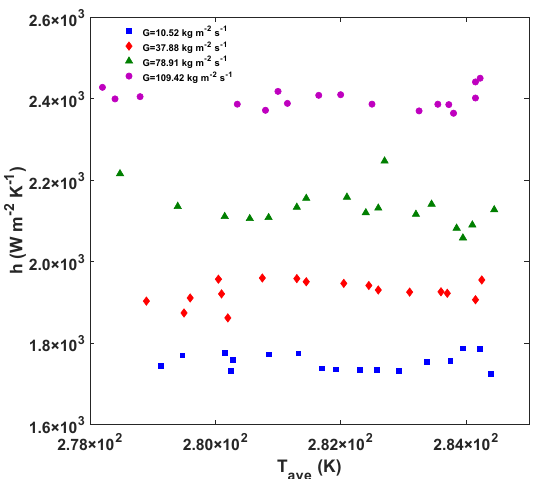
Figure 5. Heat transfer coefficient of the R22 versus the average temperature under different mass flux for p = 0.65 MPa.